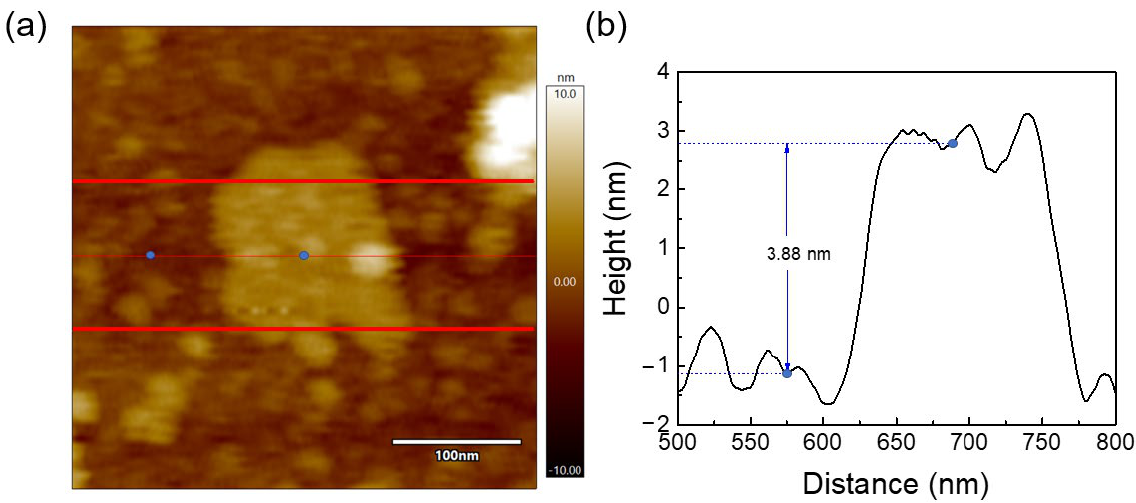
Figure 7 . ( a ) AFM image of a g-C 3 N 4 nanosheet and ( b ) corresponding average height values meas- measured between the red ured between the red lines.